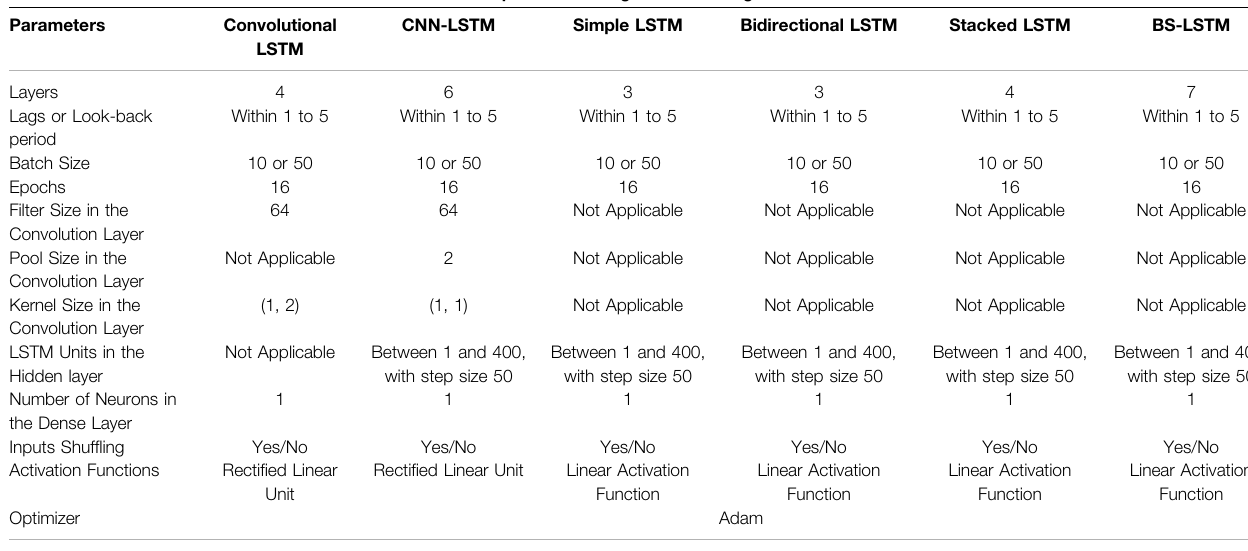
Model parameter ranges for the tangni